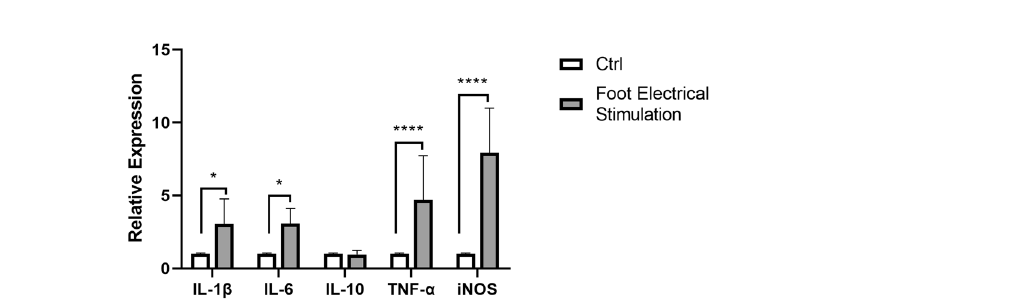
Figure 5. The levels of IL-1β, IL-6, IL-10, TNF-α, and iNOS gene in hypothalamus of control and experimental group were detected by PCR. All data are presented as mean ± SD (n = 12). * P < 0.05 versus control group, **** P < 0.001 versus control group.